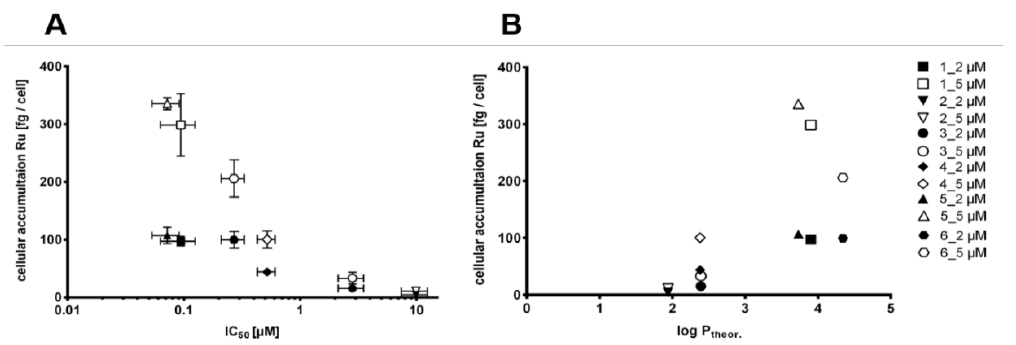
Figure 7. Semi-logarithmic plot of cellular accumulation after 2 h exposure to compounds 1 – 6 vs. their IC 50 values (96 h exposure) in SW480 cells ( A ). Correlation between drug accumulation and a theoretical lipophilicity coefficient (96 h exposure) ( B ). The symbols indicate the compound concentrations applied in cellular accumulation experiments, with filled symbols for 2 µ M and open symbols for 5 µ